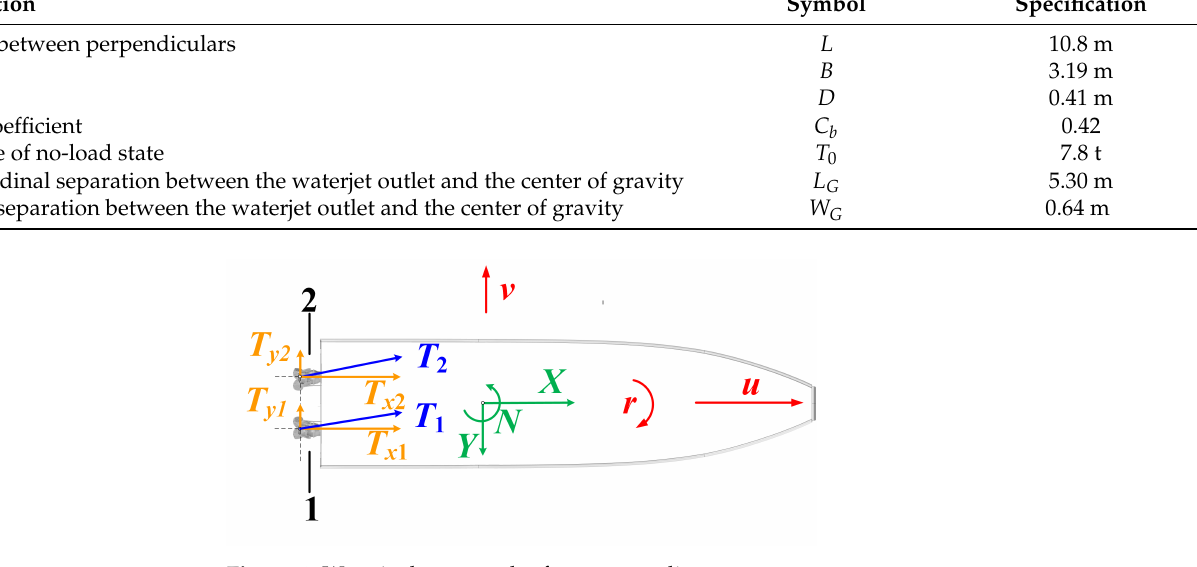
Figure 4. Waterjet layout and reference coordinate